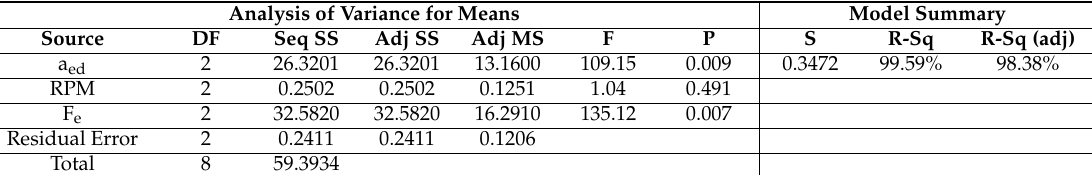
Table 5. The ANOVA values of part’s medium grinding time ( t ).